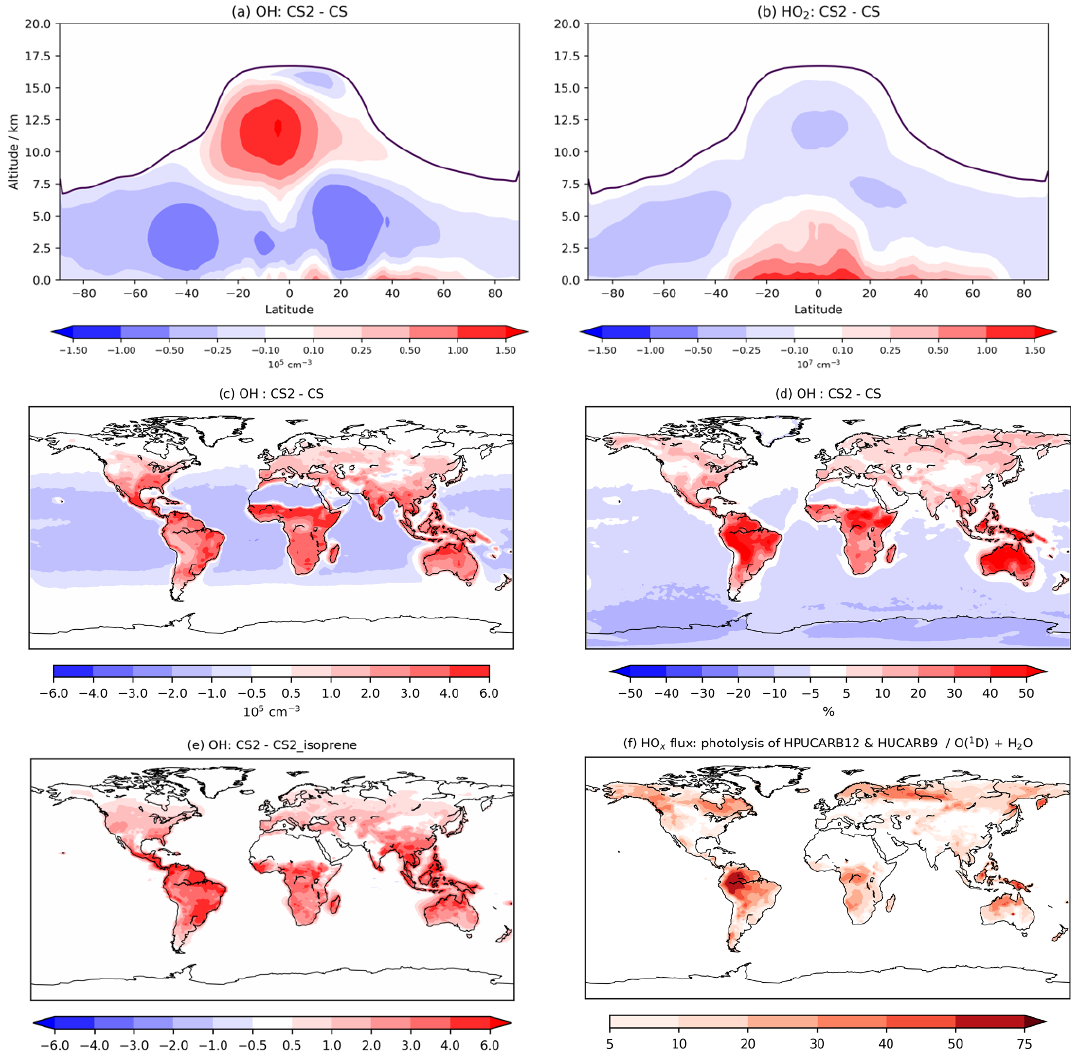
Figure 6. Annual zonal mean changes in (a) OH and (b) HO 2 between CS2 and CS, (c) absolute and (d) percentage in change in OH in lowest ∼ 500m of atmosphere, (e) the change in OH in lowest 500m between the CS2 and CS2_isoprene sensitivity test, and (f) HO x production flux from HPUCARB12 and HUCARB9 photolysis as a percentage of HO x from O ( 1 D ) + H 2 O. Dark purple lines in (a) and (b) indicate the average height of